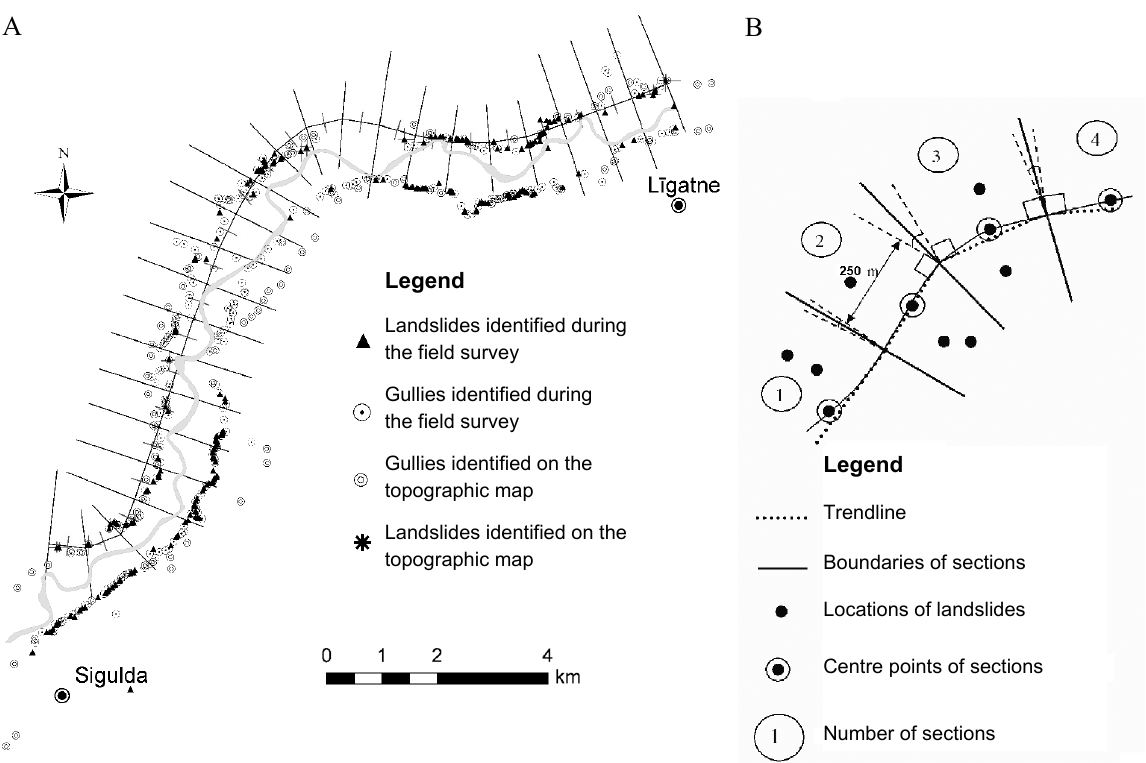
Fig. 5. Division of the right bank area in 250 m long sections (A). Construction of a projection area